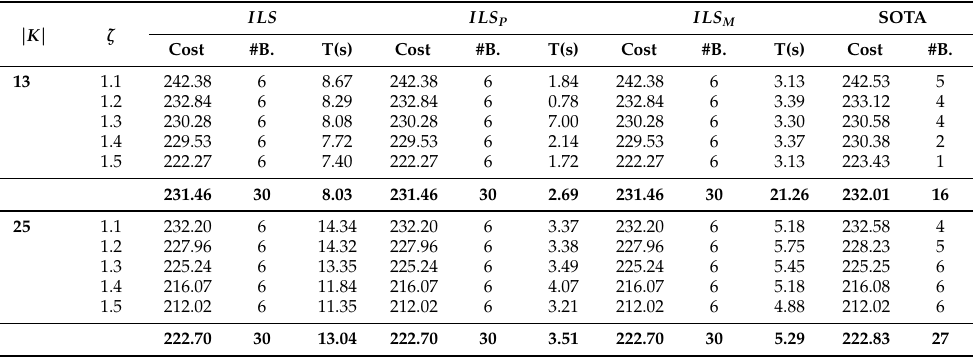
Table 5. Performance comparison for | K | = 13 and | K | = 25 occasional